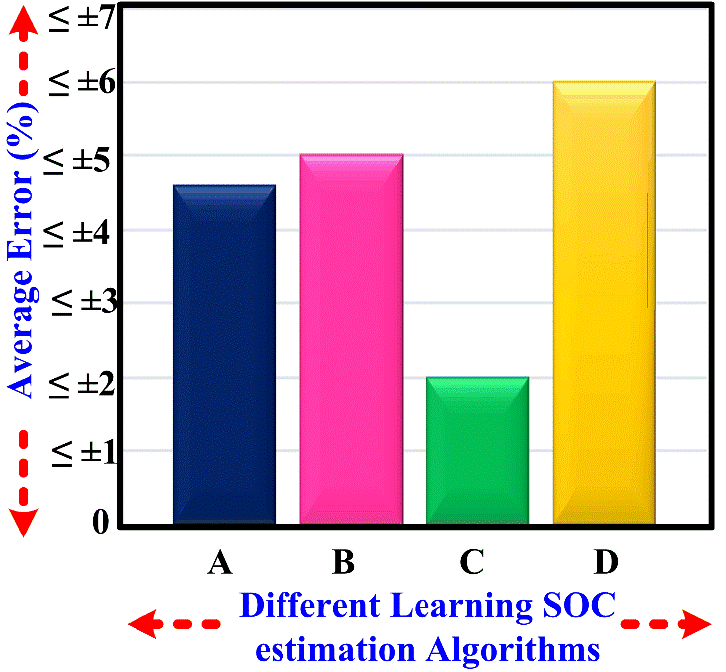
Figure 12. Comparison between the different learning SOC estimation algorithms. “A” is referred to as [137], “B” is referred to as [46], “C” is referred to as [106] and “D” is referred to as [138].